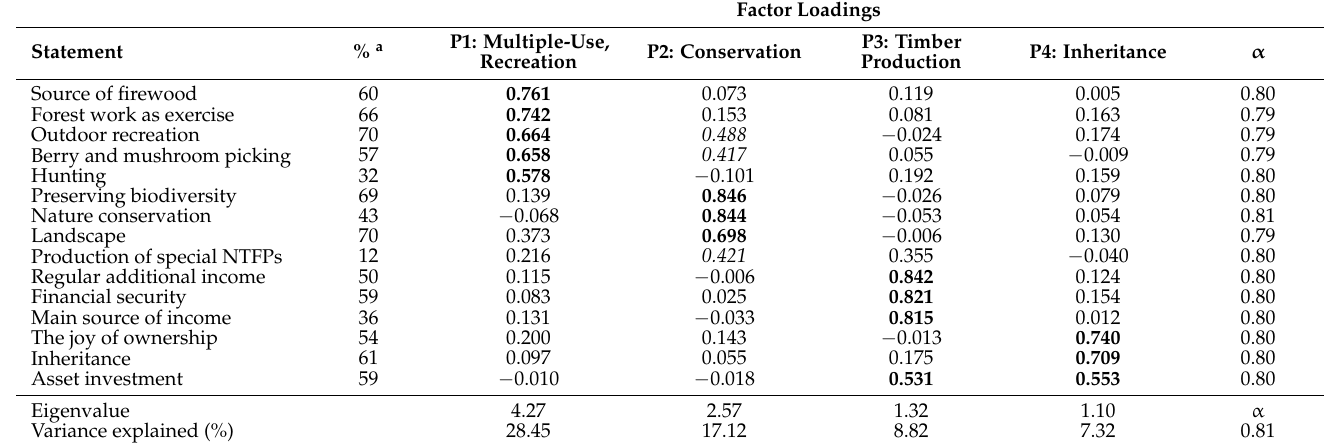
Table 3. Principal component analysis of the statements concerning forest ownership objec- tives (n = 2237). The principal components explained 61.7% of the total variance and are called P1 = Multiple-use, recreation; P2 = Conservation; P3 = Timber production; and P4 = Inheritance. Absolute loadings > 0.5 are in bold and 0.4–0.5 in italics. α = Cronbach’s